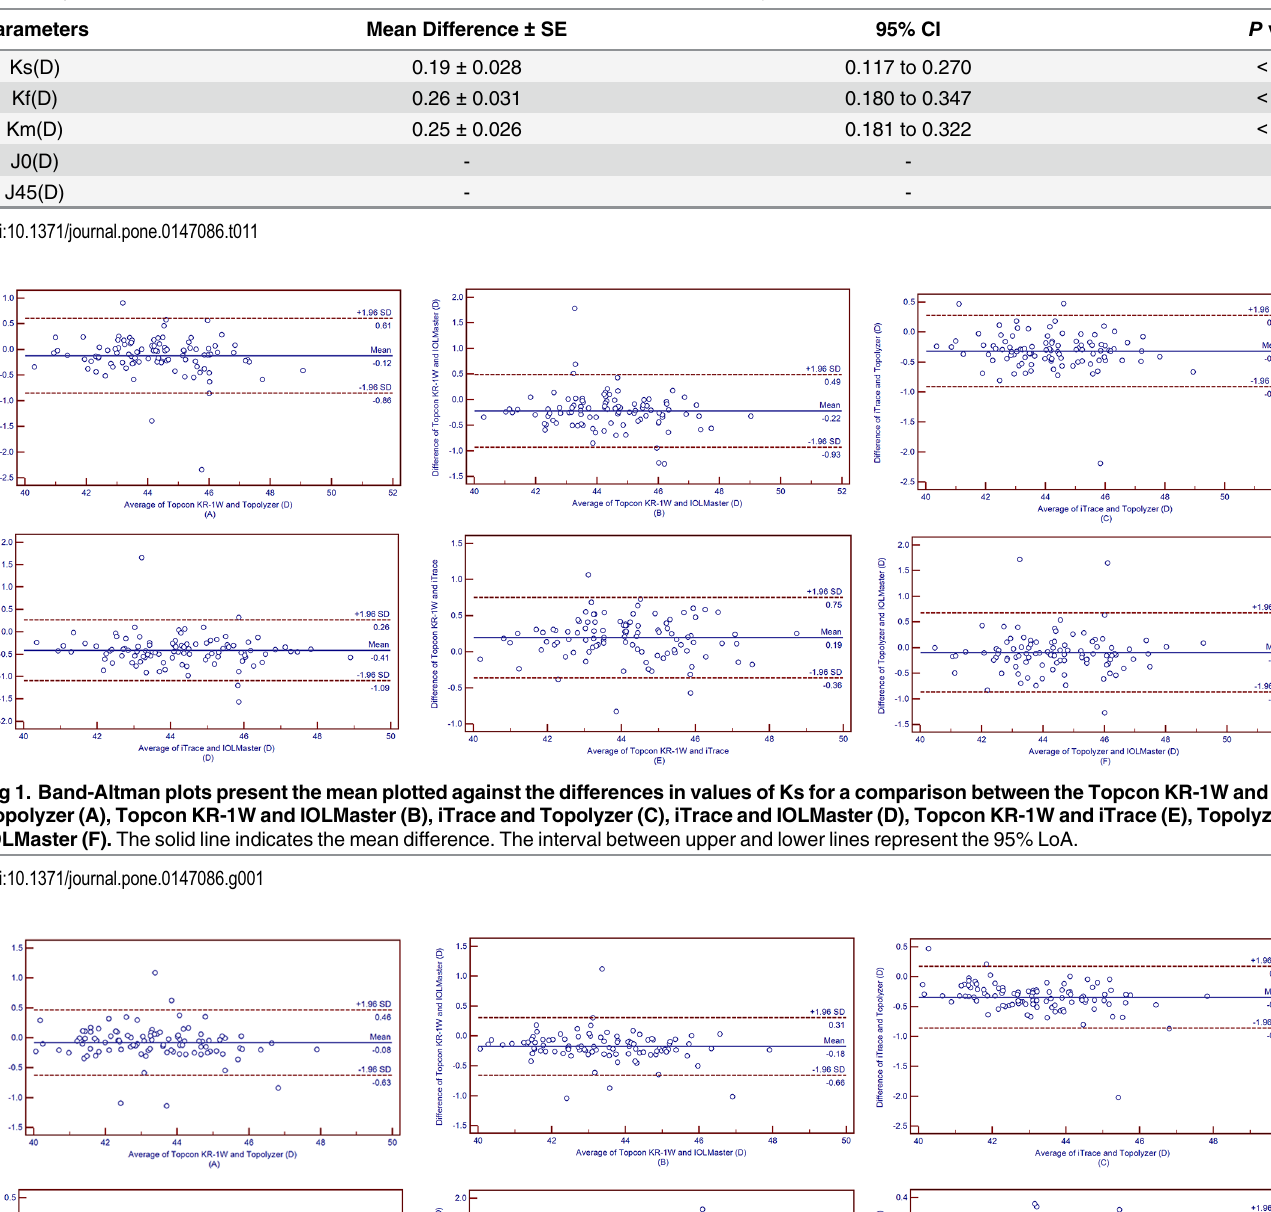
Table 11. Comparison of Ks, Kf and Km obtained by Topcon KR-1W and iTrace. (Note: Ks: steep keratometry, Kf: flat keratometry, Km: mean keratome- try, D: diopter, SD: standard Error, 95% CI: 95% consistent interval, * Bonferroni corrected.)